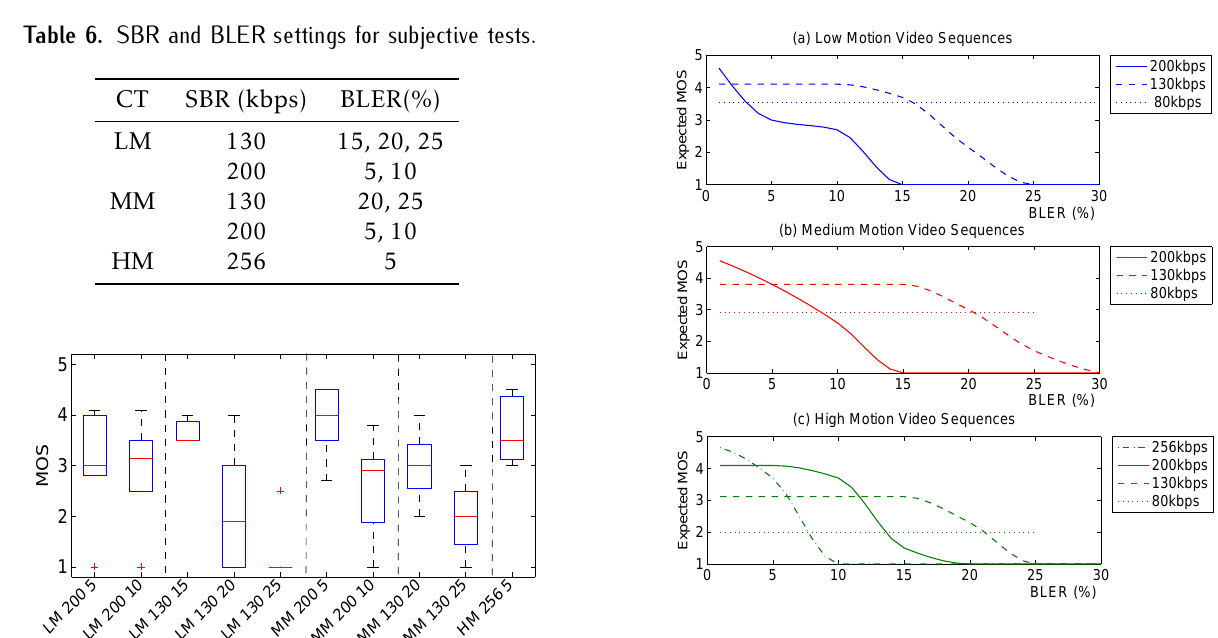
Figure 4. Evolution of expected MOS vs. BLER per CT and SBR for QVGA sequences: (a) low motion, (b) medium motion, (c) high